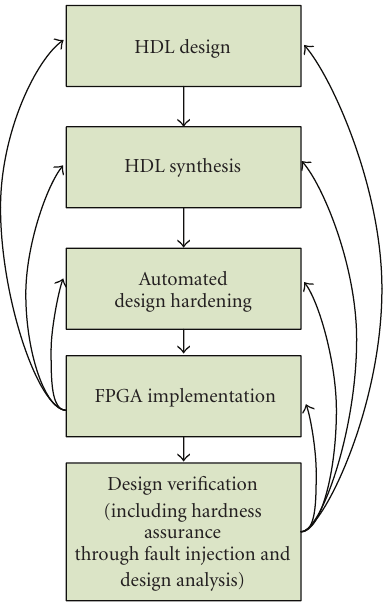
Figure 7: Recommended FPGA design flow for space (only some feedback paths